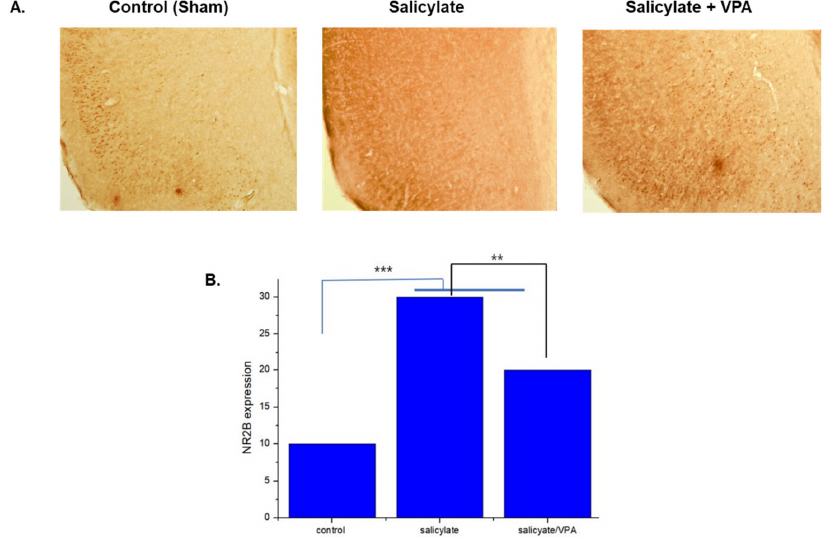
Figure 8. Immunolabeling of NR2B in the auditory cortex( A ) and protein expression levels were quantified using Image J software ( B ) The salicylate group showed increased NR2B expression compared with that of the control, but VPA attenuated salicylate ‐ induced increase in NR2B expression. ** p ≤ 0.01; *** p ≤ 0.001. One ‐ way ANOVA followed by post hoc Tukey test using GraphPad Prism 8.0.